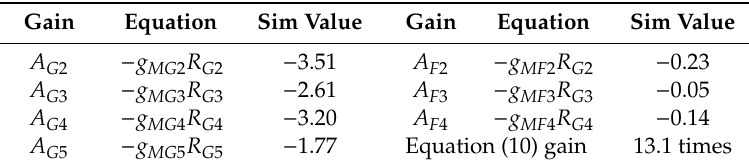
Table 4. Simulation gain calculations for DVGTIA design 1 .